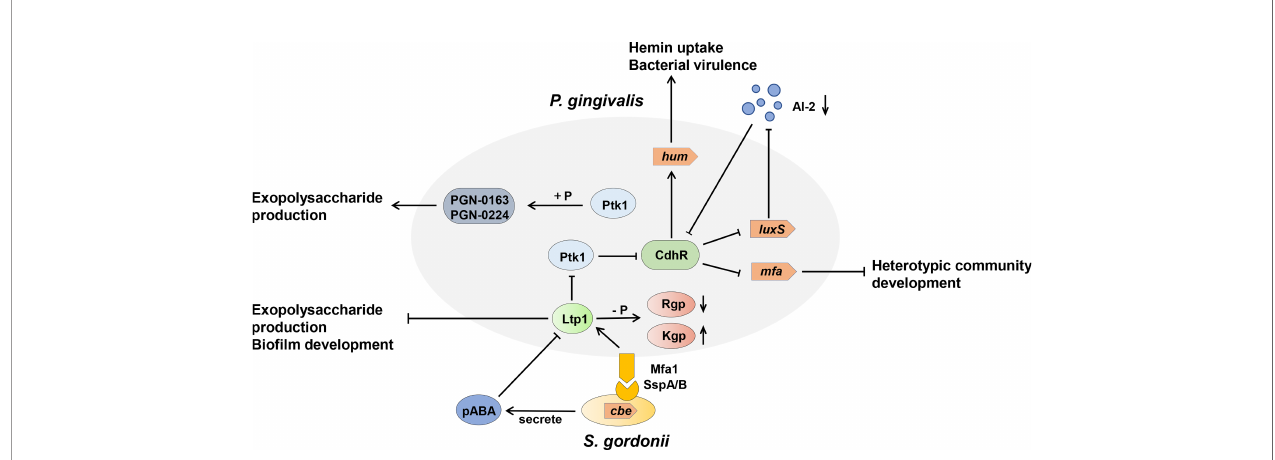
FIGURE 4 | Model of the tyrosine kinase-phosphatase dependent regulatory process governing Porphyromonas gingivalis extracellular polysaccharide production, bacterial virulence, and heterotypic community development between Porphyromonas gingivalis and Streptococcus gordonii . The interactions between P. gingivalis and S. gordonii resulting from pABA perception and direct contact of P. gingivalis Mfa fi mbriae with S. gordonii Ssp proteins, which can in fl uence Ltp1 activity, thus initiate a cascade of phosphorylation and dephosphrylation events. Ltp1 can decrease the production of exopolysaccharide and dephosphorylate gingipains Rgp and Kgp to affect colony nutrition supply. Ltp1 also dephosphorylates Ptk1 to downregulate its kinase activity, causing the upregulation of CdhR expression. CdhR represses the transcription of luxS and mfa operons to downregulate the community development of P. gingivalis and S. gordonii and promotes the transcription of the hum operon to increase the hum uptake and virulence of P. gingivalis . Lower AI-2 levels cause upregulation of CdhR and constrain the development of a heterotypic community. Conversely, protein kinase Ptk1 uses its enzyme activity to increase the production of